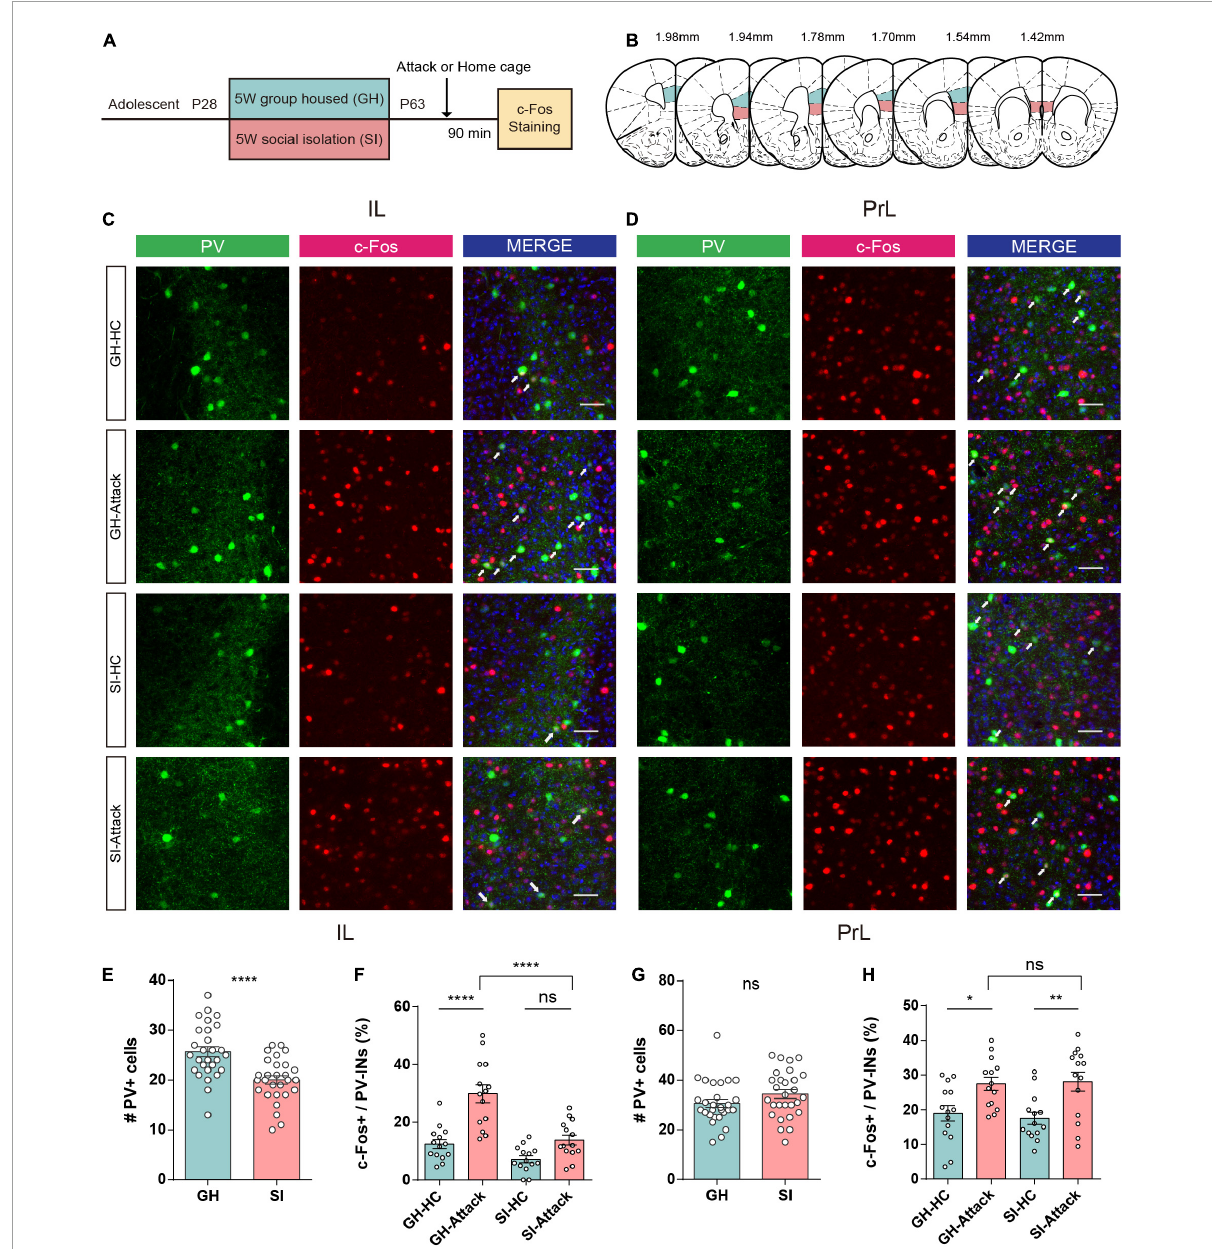
FIGURE3 Adolescent social isolation induces a decrease in the quantity and activity of PV + interneurons in the IL subregion. (A) Schematic flow chart for c-Fos immunofluorescent staining. (B) The six sequential brain atlas slides from bregma levels 1.98 mm to 1.42 mm delineating the target PFC subfields of interest. Green, PrL; pink, IL. (C,D) Confocal images showing the expression of PV + interneurons (green), c-Fos (red), and the merged image in the IL (C) and PrL (D) subregions. The brain slices obtained from GH and SI mice in the home cage or after active attacks (white arrows indicate cells colabeled for PV, c-Fos and DAPI. Scale bar, 50 µ m). (E) The number of PV + interneurons in the IL decreased after 5 weeks of social isolation during the adolescent period ( n = 28 slices/8 mice/group, GH, 25.71 ± 1.01, SI, 20.04 ± 0.84, P < 0.0001 determined by two-tailed unpaired t test). (F) GH mice show increased numbers of c-Fos-positive PV + interneurons after aggression. SI mice showed no difference in the number of activated PV + interneurons in the IL ( n = 14 slice/4 mice/group, GH-HC, 12.46 ± 1.57; GH-Attack, 29.90 ± 3.10; SI-HC, 7.19 ± 1.18; SI-Attack, 13.84 ± 1.72, **** P < 0.0001 determined by two-way ANOVA with Tukey’s multiple comparison test). (G) No changes occurred in the number of PV + interneurons in the PrL after 5 weeks of social isolation during adolescence ( n = 28 slices/8 mice/group, GH, 30.68 ± 1.64, SI, 34.43 ± 1.79, P = 0.13 determined by two-tailed unpaired t test). (H) The number of c-Fos-positive PV + interneurons increased after aggression compared to the home cage condition in the PrL of both GH and SI mice, and there was no obvious difference between the GH-attack and SI-attack groups (n = 14 slices/4 mice/group, GH-HC, 18.94 ± 2.27; GH-Attack, 27.46 ± 1.91; SI-HC, 17.49 ± 1.77; SI-Attack, 28.06 ± 2.74, * P < 0.05, ** P < 0.01 determined by two-way ANOVA with Tukey’s multiple comparison test). All data in (E–H) are presented as the mean ± SEM. GH: group-housed; SI: social